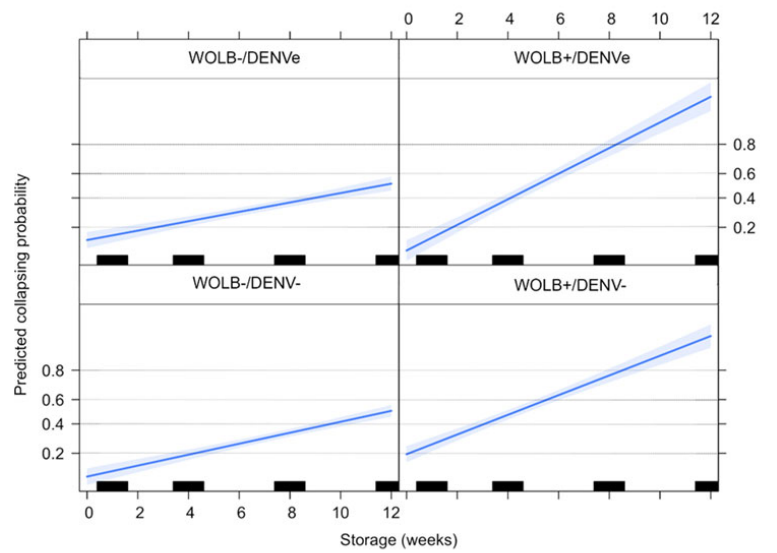
Figure 6. Egg collapsing probability estimated from logistic model according to Wolbachia presence, DENV exposure status and egg storage time. Bars represent the weeks in which eggs were checked for collapsed eggshells, whereas the blue line shows the estimated effect of storage time on egg collapsing probability. 3.7. Quiescent Eggs Show a Decrease in Fertility, Especially on Wolbachia-Infected Groups As expected, the egg hatching decreased over time. Eggs from the WOLB − group hatched at rates of 85.4 (DENV − ) and 78.1% (DENVe) after one week of storage, whereas 46.9 and 64.8% of those from the WOLB+/DENV − and DENVe groups hatched, respec- tively. The discrepancy in egg hatching according to the presence of Wolbachia